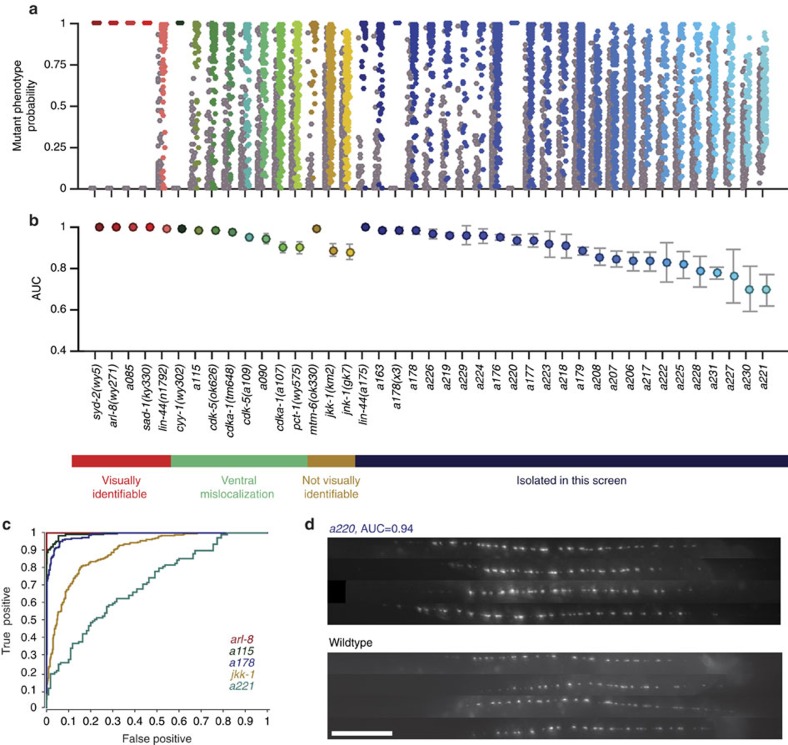
Logistic regression models reveal the degree of separation between mutant and wild-type populations.(a) Probability in the mutant phenospace for each animal in the wild type and mutant populations. Each column is scored by a different logistic regression model. Populations are divided into groups, and ranked by severity. (b) AUC for each logistic regression model is an indicator of the discriminating power of each model. AUC was quantified in a fivefold cross-validation. Error bars represent s.d. of the AUC form each testing fold. Genotypes are ordered by groups (visually identifiable mutants, ventral mislocalization mutants, not-visually identifiable mutants and mutants isolated in this screen). In each group, strains are ranked from most identifiable to less identifiable, as measured by AUC. (c) Receiver operating characteristic (ROC) curve for five populations with varying degrees of phenotypic severity captures the degree of separation by sweeping a discriminating threshold on the computed phenotype probability. (d) Images for mutant a220, which shows no obvious phenotype but is quantitatively distinguishable from wild type, and for wild type. Scale bar, 10 μm. Sample sizes, statistical analysis for model creation and feature selection are listed in Supplementary Information.